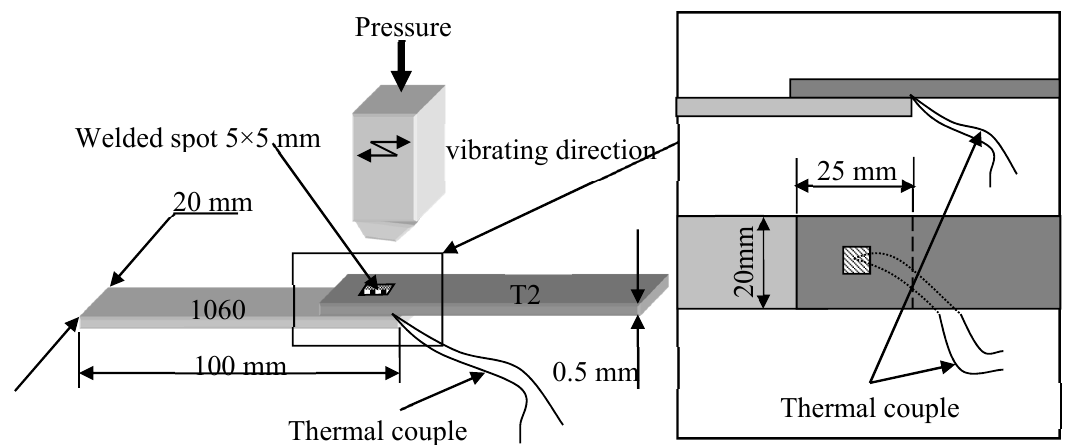
Figure 1. The sketch of a welded specimen.